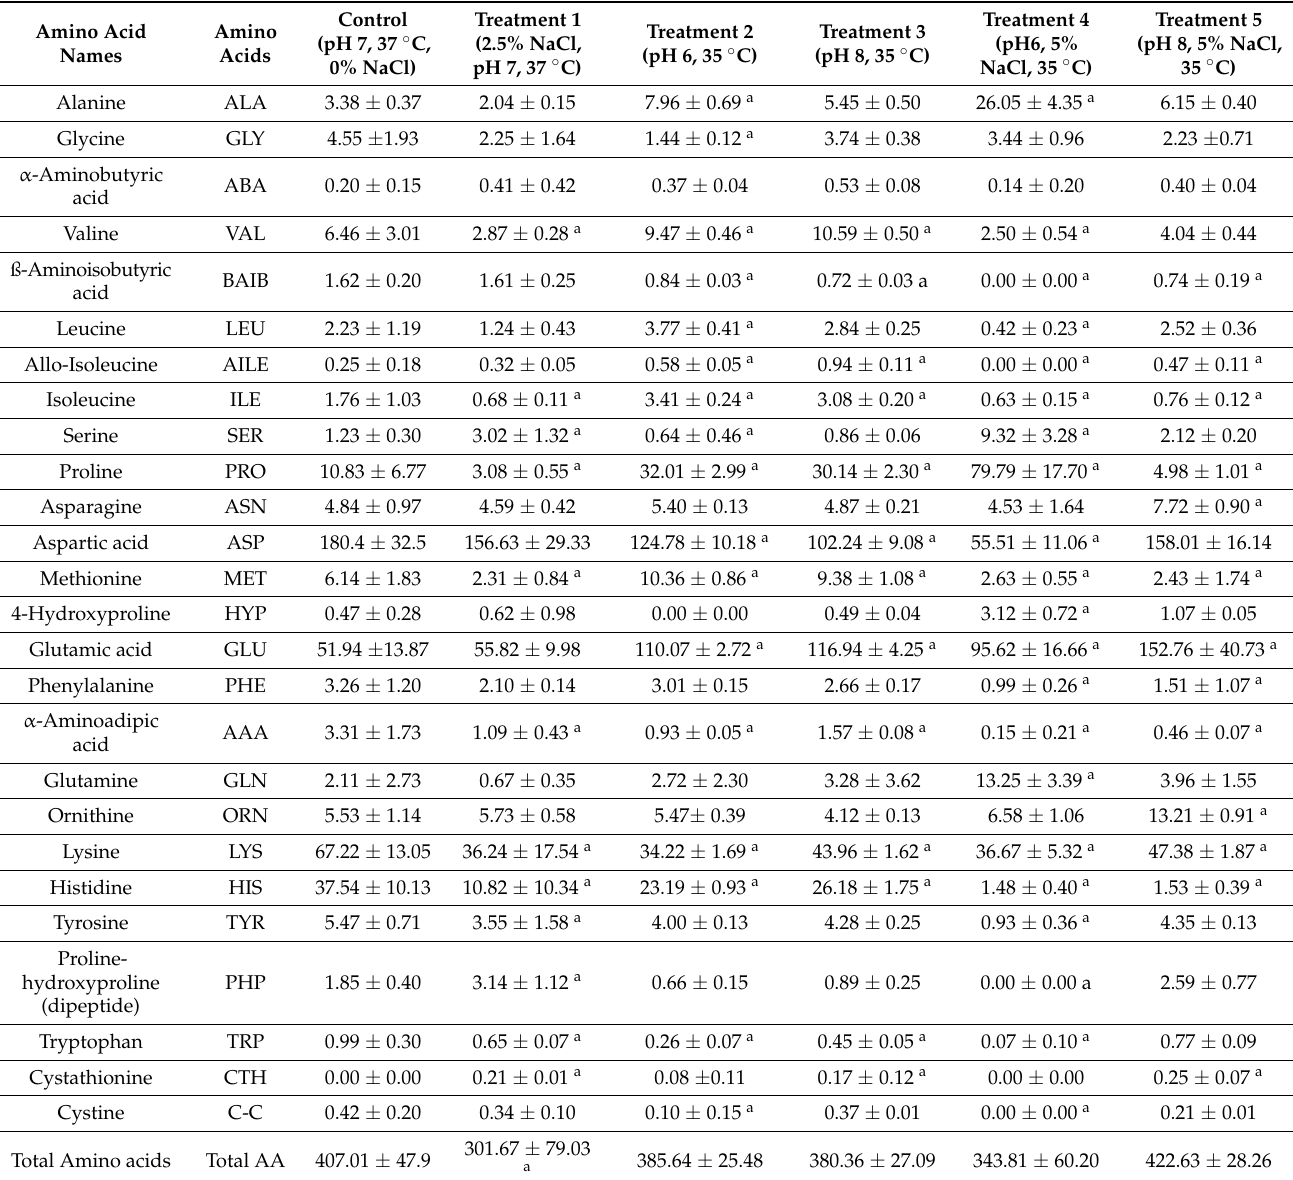
Table 1. The concentrations of S. aureus cytoplasmic amino acids following growth under differing experimental regimes. The concentration is expressed as nmol mg − 1 dry cell weight (Mean + SD, p <